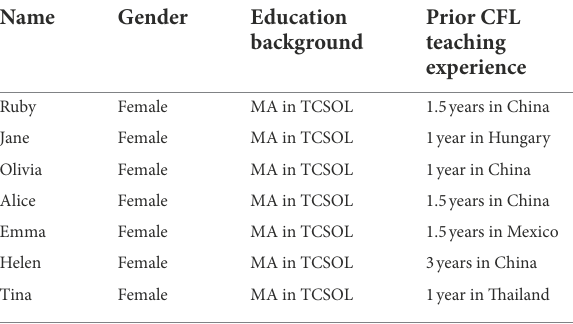
TABLE 1 Background information of novice Chinese as a foreign language (CFL)